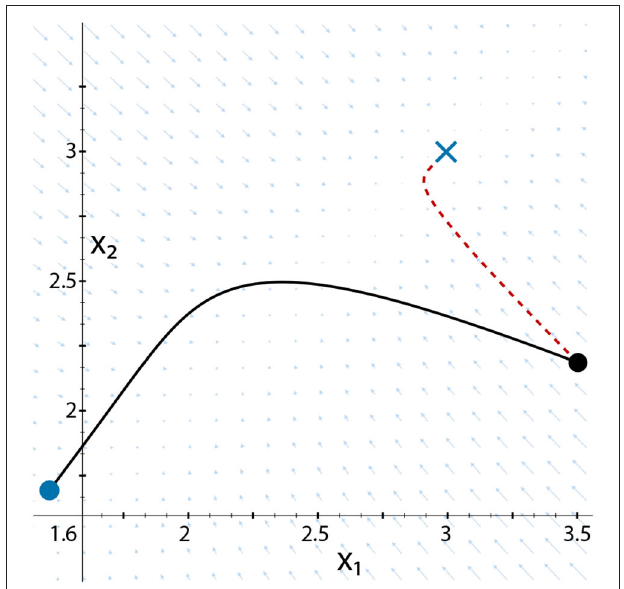
FIGURE 4 | Phase plot illustrating the dynamics of the knowledge stocks x 1 ( t ), x 2 ( t ) of two firms Equation (2), (red dashed line) u 1 u 1 =